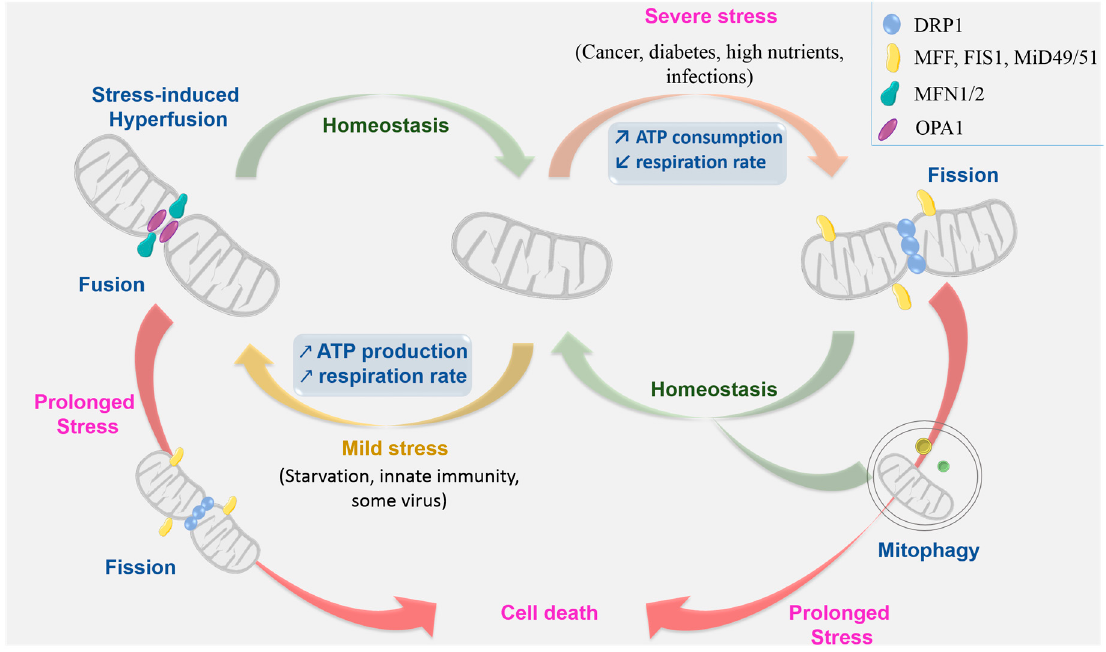
Figure 1. Mitochondrial dynamics: machinery and context. Mitochondria continuously undergo two membrane related opposite processes: fission and fusion. According to cell context and circumstances, the equilibrium between fission and fusion could be altered and the balance leans towards one of these two processes. When cells are subjected to mild stresses, mitochondria form an elongated and interconnected network, they resist mitophagy and increase ATP production to adjust to cellular stresses as nutrient deprivation. Conversely, in the case of severe stresses, mitochondria present a fragmented form. Failure of any of these pathways to maintain homeostasis, results in elimination of the entire mitochondria via mitophagy, or, if stress is prolonged, via apoptosis. DRP1: Dynamin-Related Protein 1; MFF: Mitochondrial Fission Factor; FIS1: FISsion 1; MiD49/51: MItochondrial Dynamics 49/51; Mfn1/2: Mitofusin 1/2; OPA1: OPtic Atrophy 1.